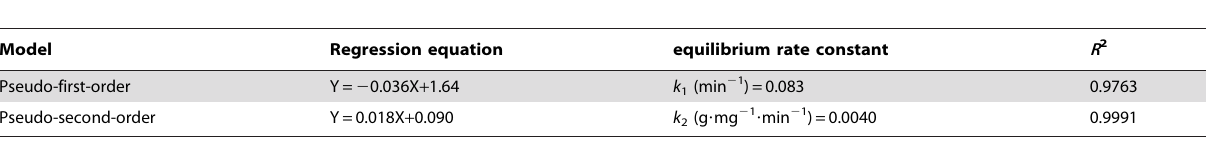
Table 3. Parameters of pseudo-first-order and pseudo-second-order kinetic models.